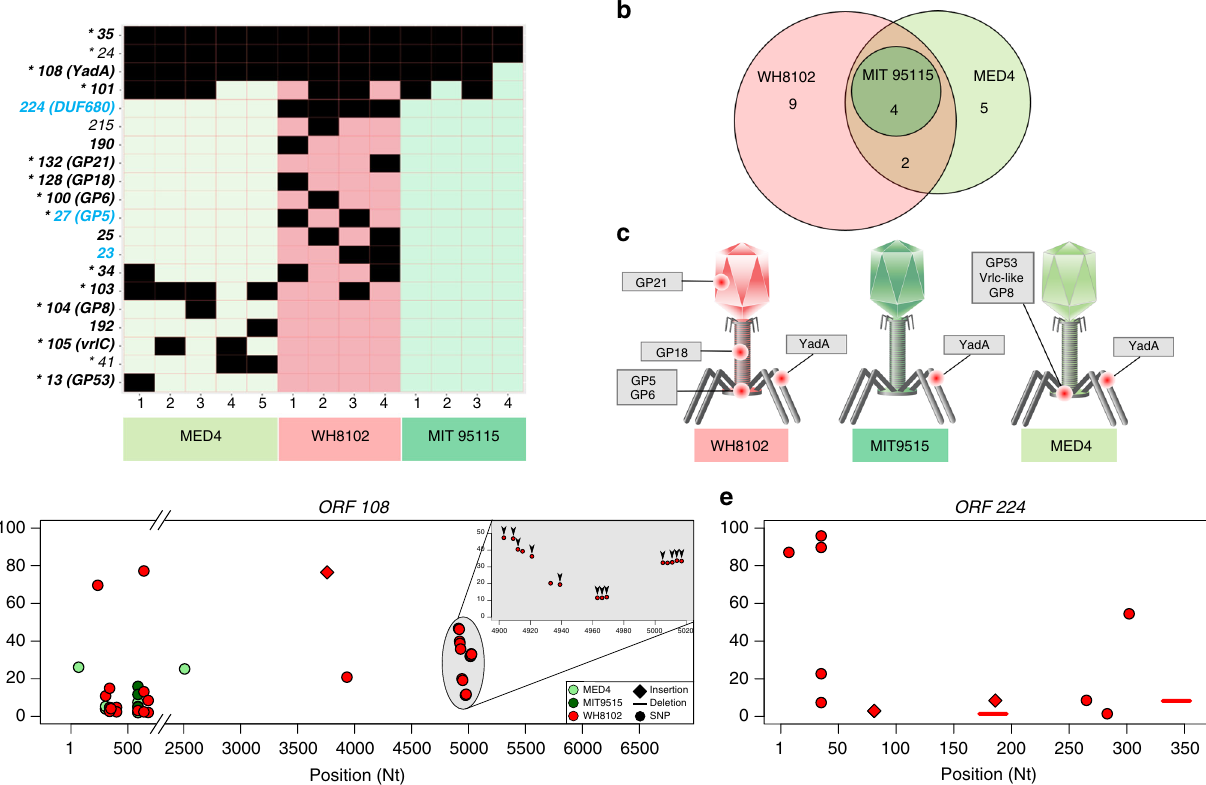
Fig. 4 Discrete sets of structural genes are mutated in sub-optimal hosts. a Mutated genes in each evolved population. Each row represents one of the 20 mutated phage genes; columns represent evolved populations. Black cells indicate mutations identi fi ed in a particular gene. Genes in bold black type are predicted to be expressed during the late-phase of infection (and most have a structural role in the assembly of the virion particle). Genes in bold blue type are predicted to be middle-phase expressed genes. Genes marked with an asterisk encode proteins that were identi fi ed by mass spectrometry as part of the assembled viral particle. b Mutated genes in populations evolved in the optimal host are also mutated in other populations. Venn diagram showing the overlap of mutated genes in phage populations, grouped by the host they evolved in. c Location of mutated proteins in the virion particle. Each phage diagram represents populations evolved in a speci fi c host: Prochlorococcus MIT9515, Prochlorococcus MED4, and Synechococcus WH8102. Protein names correspond to panel a . All proteins, excluding gp18 and gp21, are located in the tail fi bers and baseplate, responsible for host recognition, attachment and infection. d Genetic map of ORF108 (YadA domain-containing structural protein) shows increased diversity and speci fi city of mutations in populations evolved in sub-optimal hosts. X- axis shows the positions along the gene, mutation frequencies are on the Y- axis. Gray inset plot is a zoom-in of a 120 base- pair long region which is enriched in 15 synonymous SNPs, all in the same population which evolved in WH8102 (#3). Black arrows are positioned over mutations that result in codon optimization to the host tRNA repertoire. e Genetic map of ORF224 (DUF680-containing protein) showing high diversity of mutations but only in populations evolved in Synechococcus WH8102. Raw data can be found in Supplementary Tables 2,